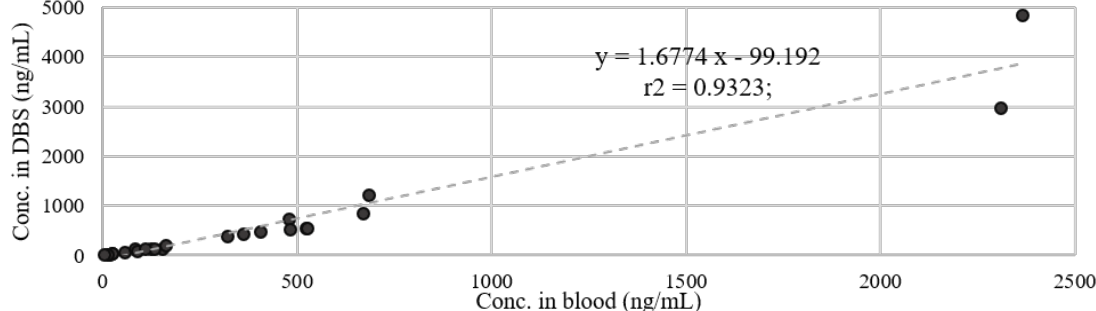
Figure 1. Comparison between cardiac blood and DBS concentrations in simultaneously collected specimens from 16 post-mortem cases.